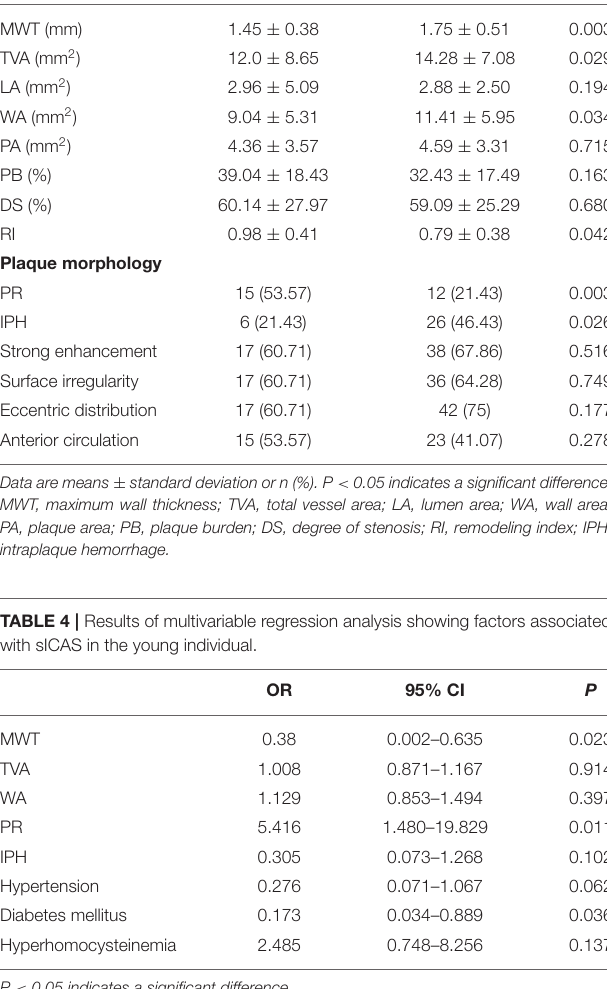
TABLE 3 | Plaque features in the two groups. Plaque features